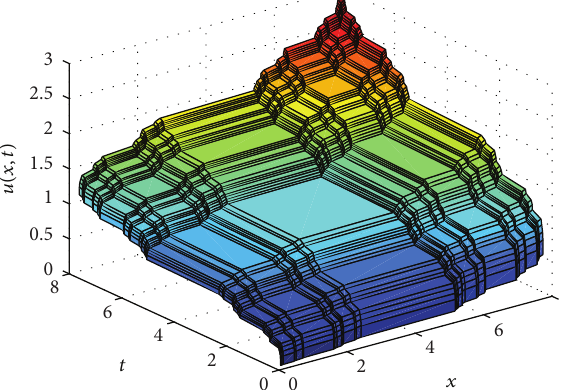
Figure 1: Solution for the one-dimensional heat equations with a fixed value 𝛼 = ln 2/ ln 3